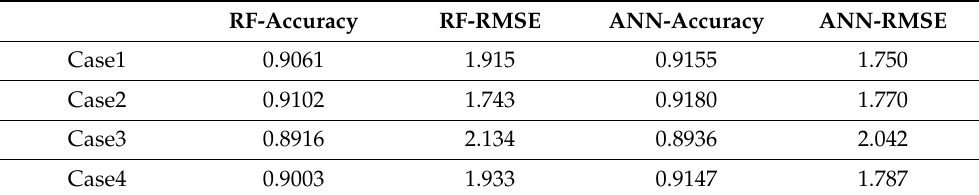
Table 6. The Accuracy and RMSE results of all cases from 11/7 to